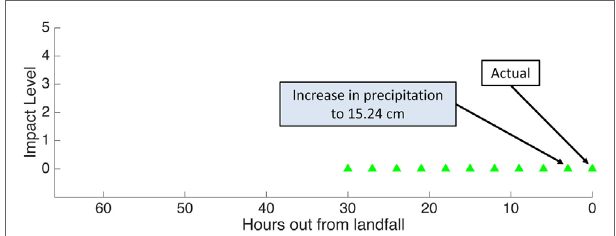
FigUre 7 | 2016 Hurricane Impact Level (HIL) Model forecasting results, with comparison to actual impact level, for Tropical Storm Colin. Model confidence in forecasted impact level shown in